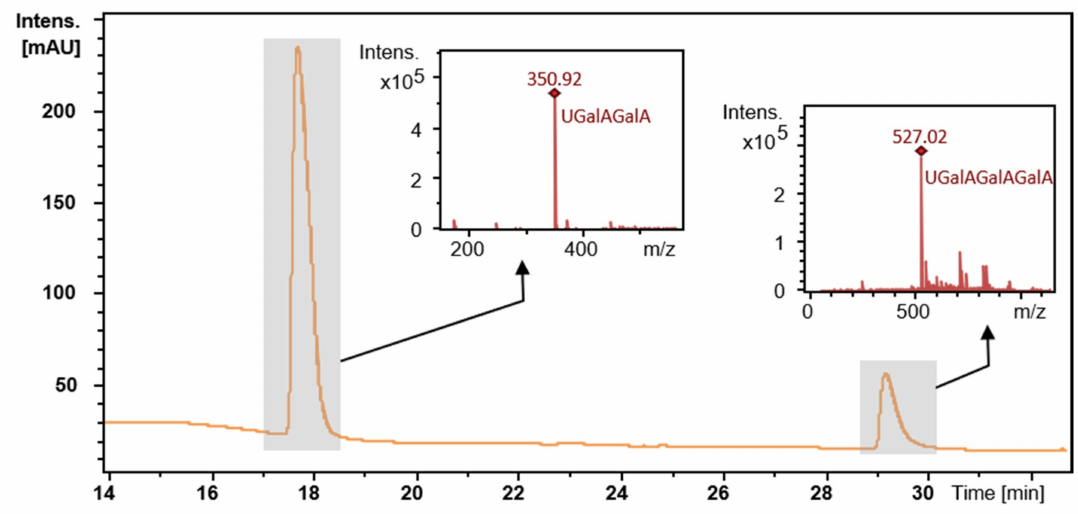
Figure 7. Analysis of the oligomers released from PGA by ultra-performance liquid chromatography-tandem mass spectrometer (UPLC-MS). The oligosaccharides separated by UPLC was further analyzed by ESI-MS analysis (small